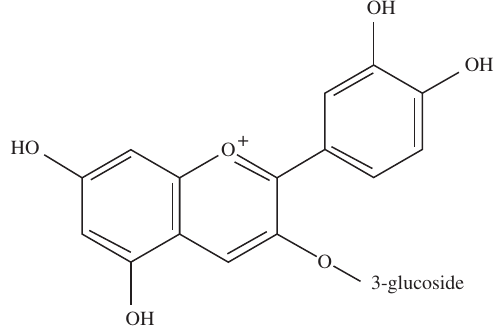
Figure 1. Molecular structure of the cyanidin.